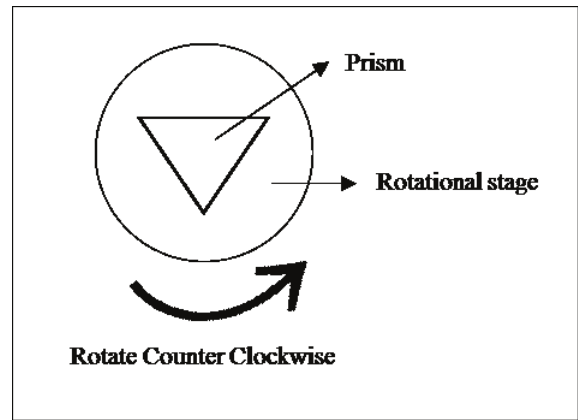
Fig. 7. Rotating the prism in counter clockwise direction.